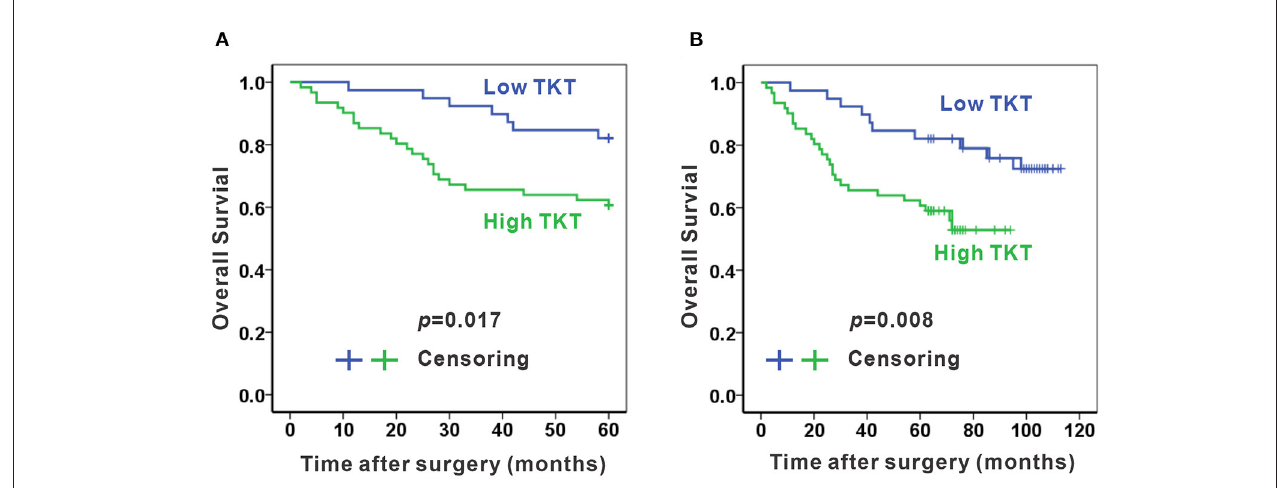
FIGURE 3 | High TKT expression predicts poor 5-year and 10-year survival. High TKT expression was associated with lower 5-year overall survival (A) and lower 10-year overall survival (B)